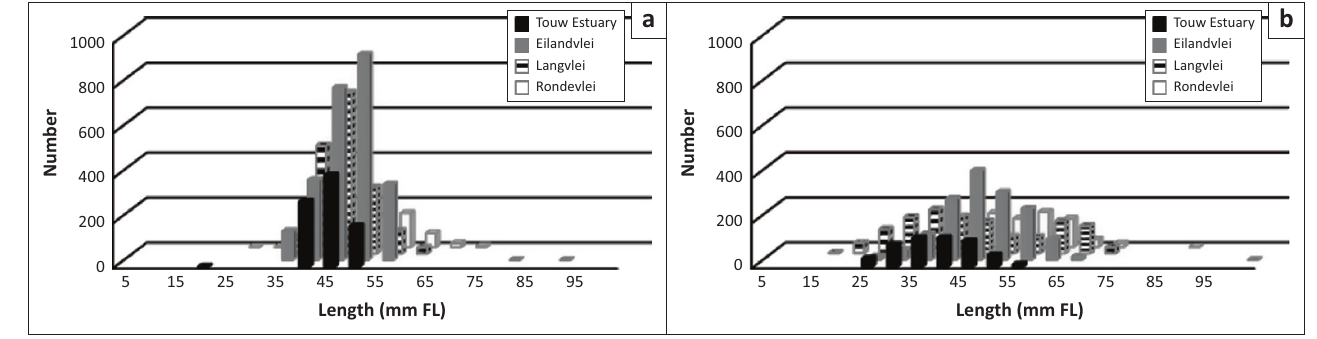
FIGURE 4: Length frequency of (a) Gilchristella aestuaria and (b) Atherina breviceps captured in the Wilderness Lakes System between April 2010 and May 2011.